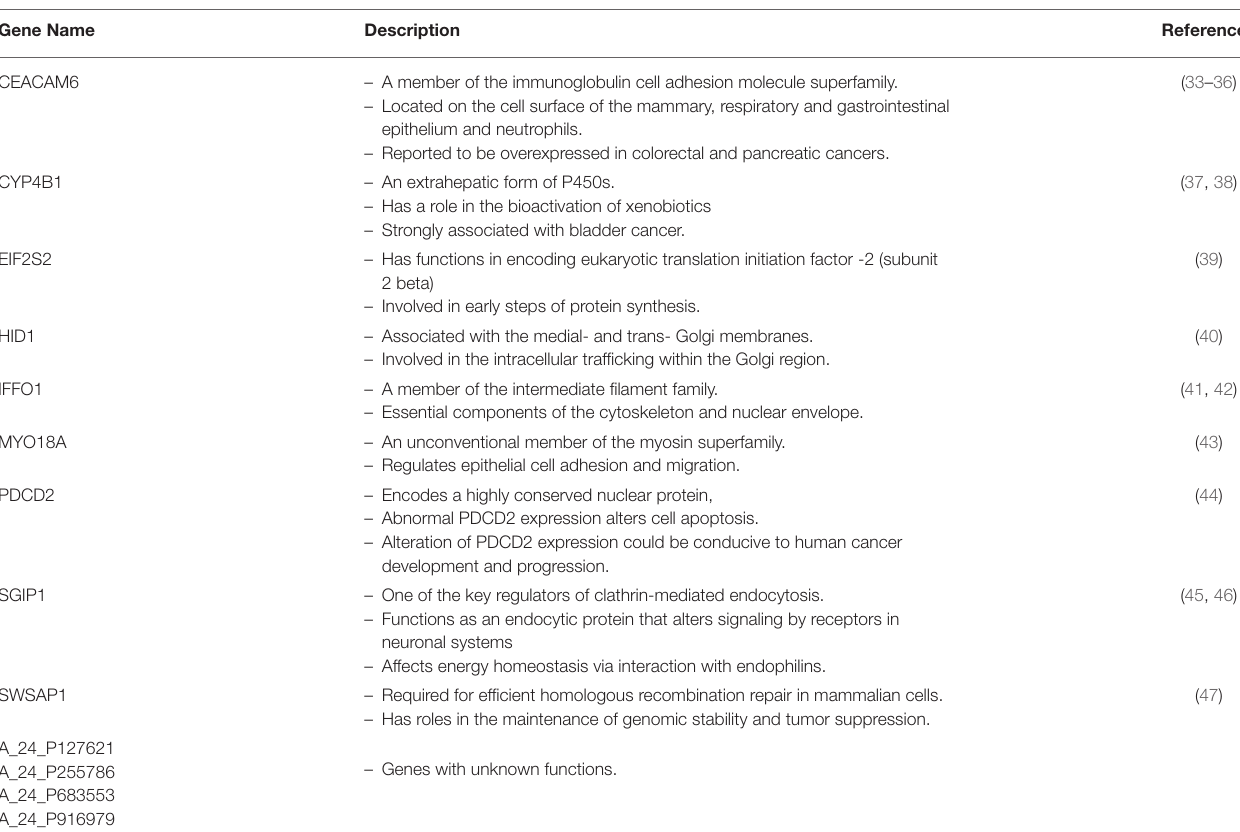
TABLE 2 | Differentially co-expressed genes represented in the core